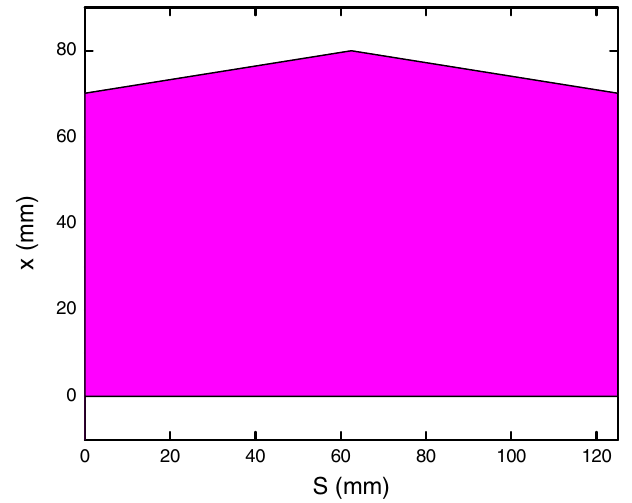
FIG. 9. Geometry of the simulated wedge. Note that both W 1 and W 2 wedges have the same dimensions.